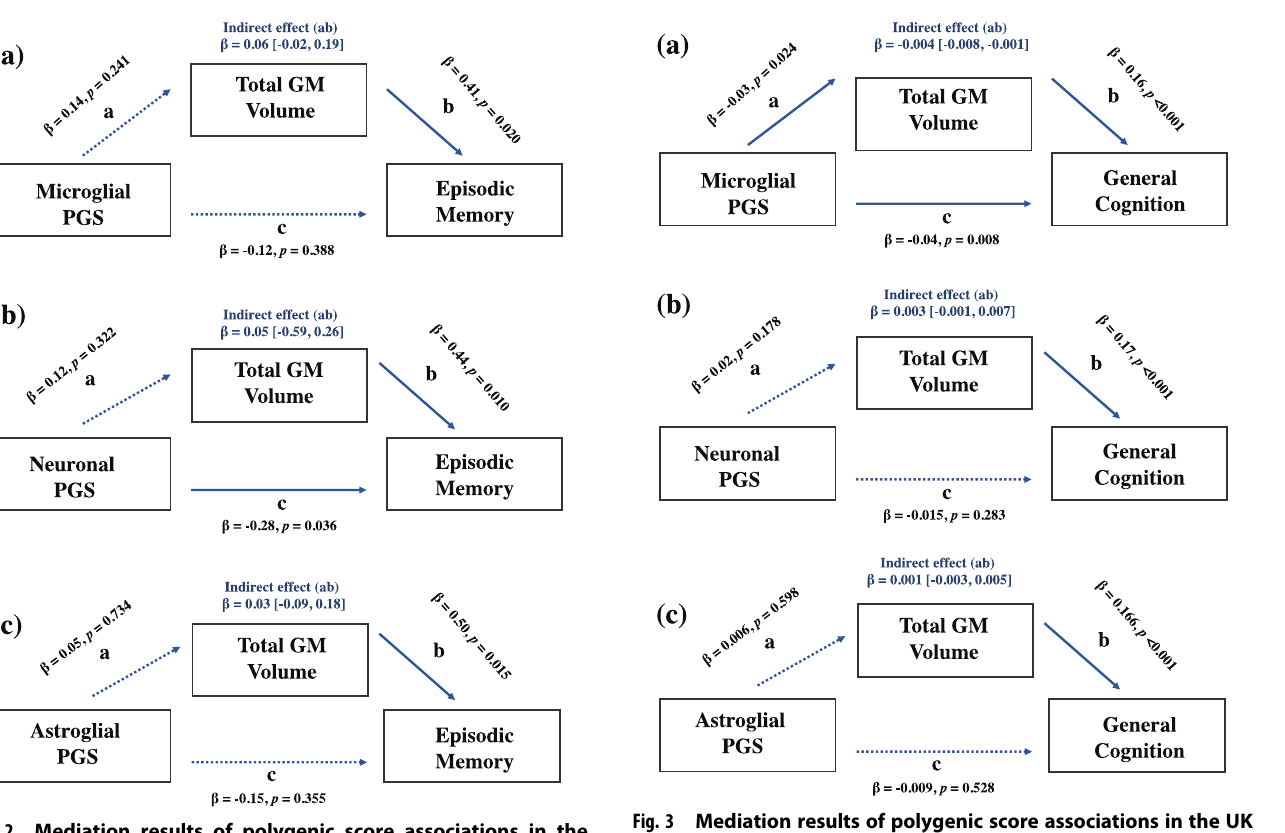
Fig. 2 Mediation results of polygenic score associations in the discovery sample. Values are standardised estimates; dashed paths are nonsigni fi cant. Indirect estimates are reported (a*b). a The effect of the microglial polygenic score on episodic memory as mediated via grey matter volume. b The effect of the neuronal polygenic score on episodic memory as mediated via grey matter volume. c The effect of the astroglial polygenic score on episodic memory as mediated via grey matter volume. Table 2. Cognitive comparison of the microglia, neuronal and astroglial polygenic scores.